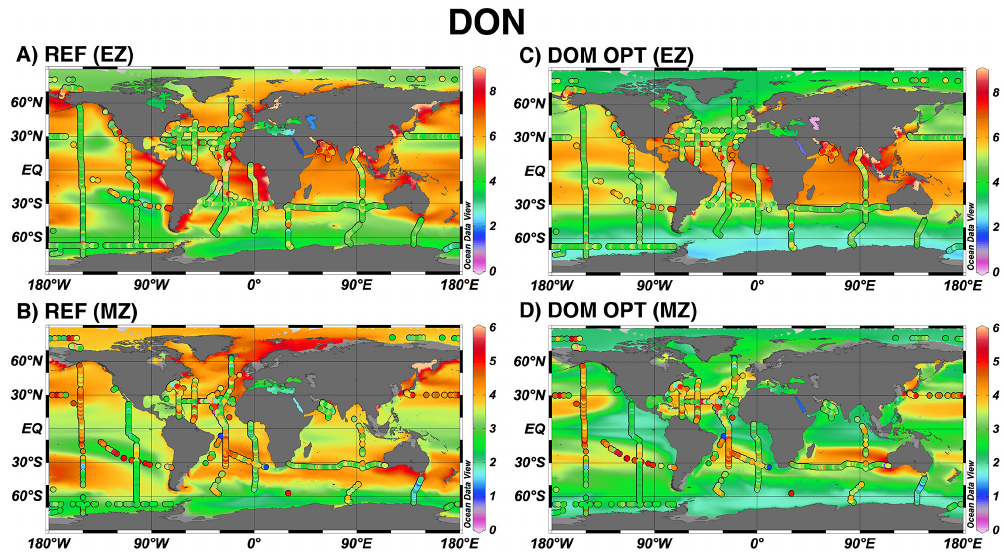
Figure 4. Plots of simulated total [DON] (µM; colored contours) with observations (colored dots) for the REF simulation at (a) the surface (EZ) and (b) 200m (MZ), and for the DOM OPT simulation at (c) the surface (EZ) and (d) 200m (MZ).